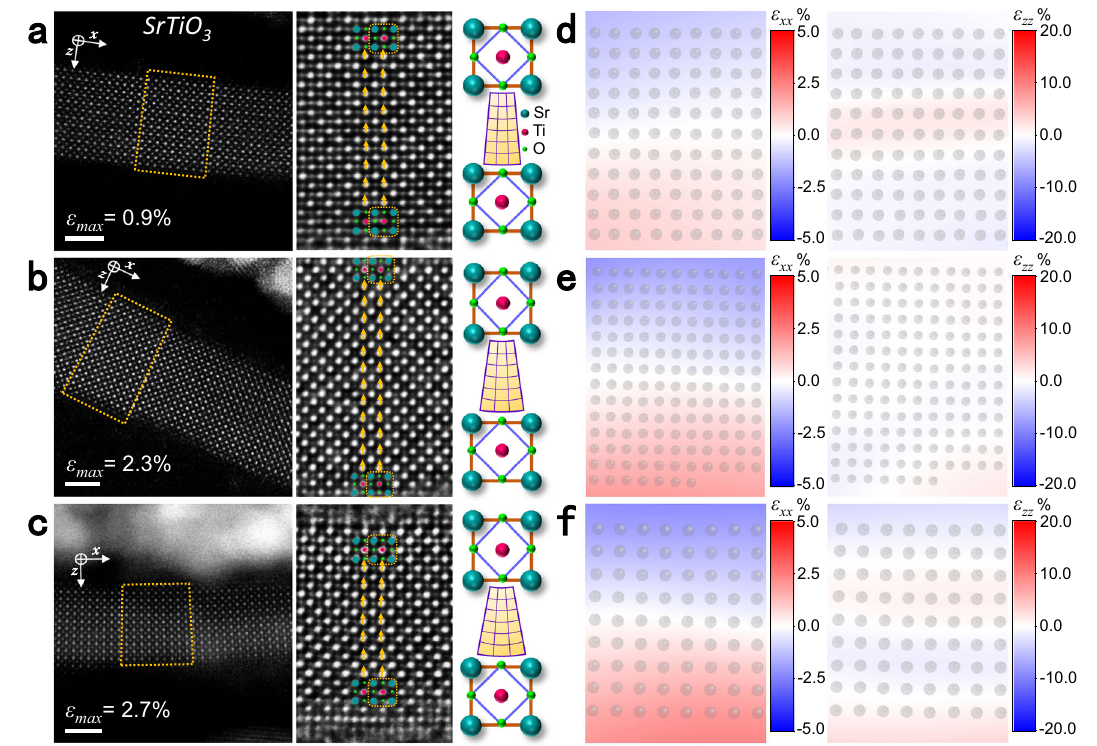
Fig. 2 | Bending behavior of STO membranes. a – c STEM-HAADF images (left) of bent STO taken from the different bent regions with a strain gradient ε xx,z of 4.2×10 6 m − 1 , 9.7×10 6 m − 1 , and 1.5×10 7 m − 1 , respectively. Middle STEM-iDPC images taken from yellow trapezoid regions show the position of Sr, Ti, and O atomic